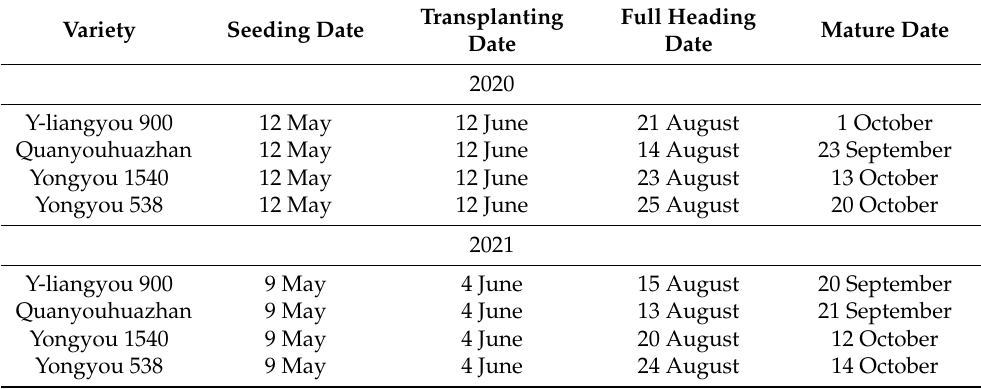
Table 2. Typical crop husbandry associated with the genotypes used here.